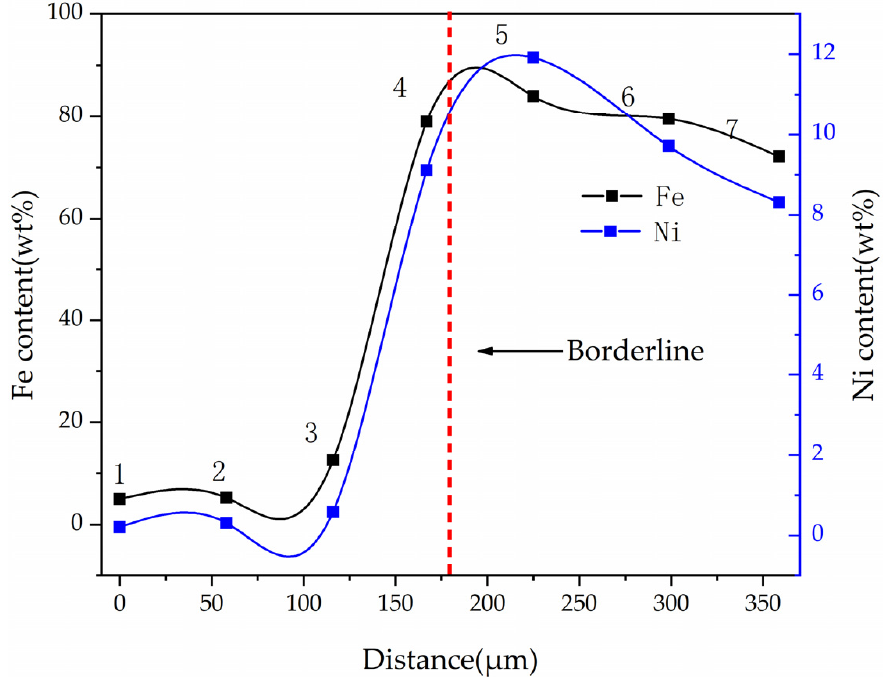
Figure 17. Ni and Fe contents of different points at cross section of DC3.